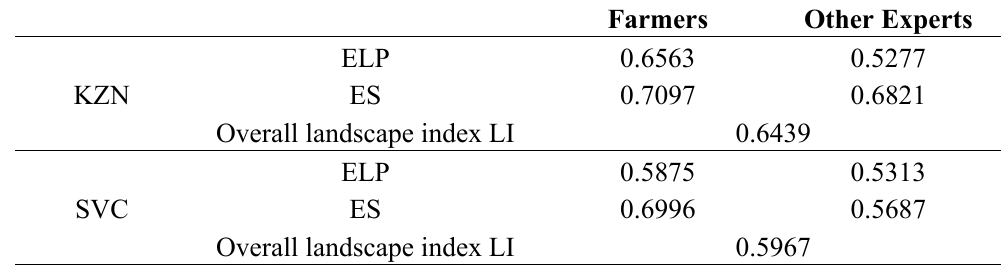
Table 3. Means of ELP and ES sub-indices values across sites as a function of stakeholders. ES, Ecosystem Services; ELP, Ecoagriculture Landscape Performance; KZN, KwaZulu-Natal; SVC, Savé Valley